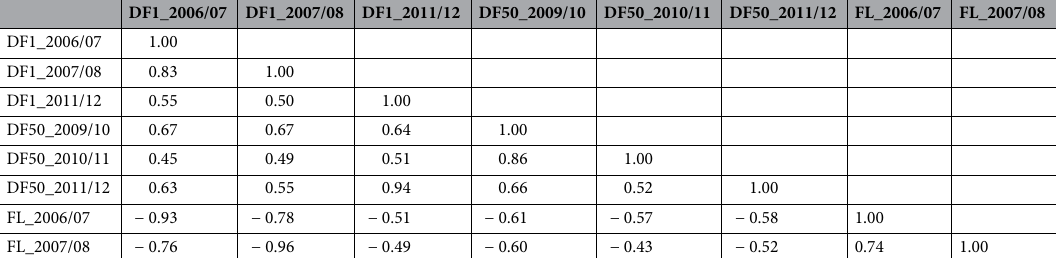
Table 3. All the new markers fit the expected 1:1 Mendelian ratio except for Vf_FT which showed a distorted segregation skewed towards the Vf6 allele (Table 3). The linkage map, spanning 4.184 ‬ cM, consists of six main linkage groups and five smaller arrays (Fig. 2). The existence of common markers with previous consensus